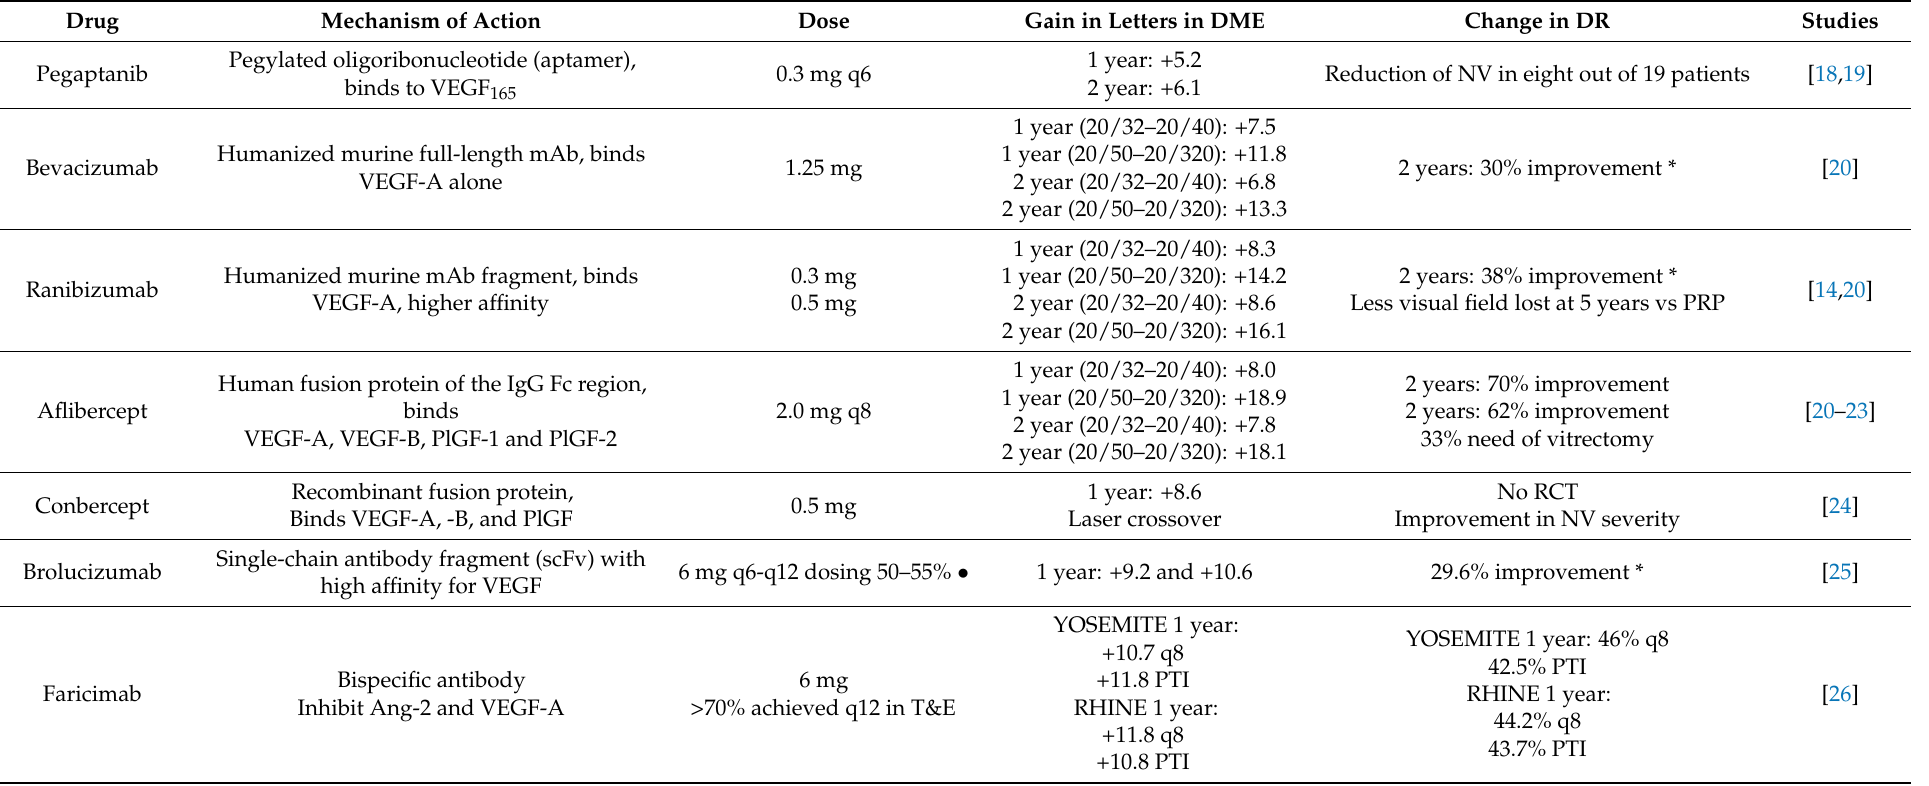
Table 1. Anti-VEGF therapies in diabetic macular edema and diabetic retinopathy. Drug Mechanism of Action Gain in Letters in DME Change in DR